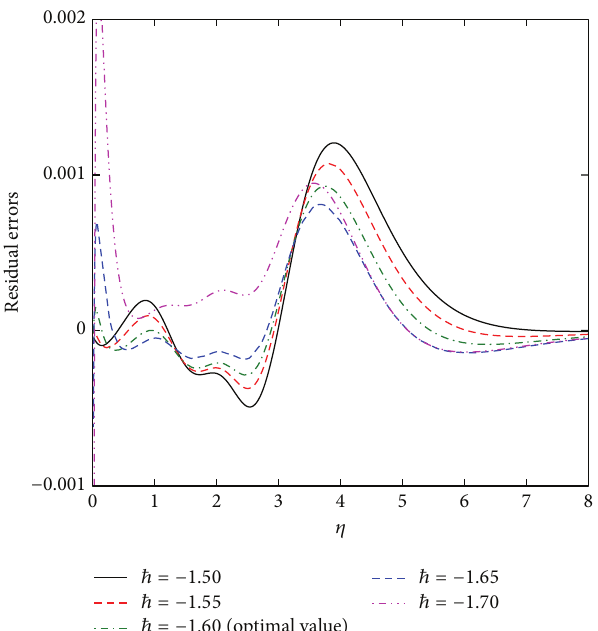
Figure 5: The residual errors for temperature profile when 𝑘 1 = 0.8 , = 0.5 , 𝑚 = 0.5 , and Pr = 5.0 . 𝜆 𝑇